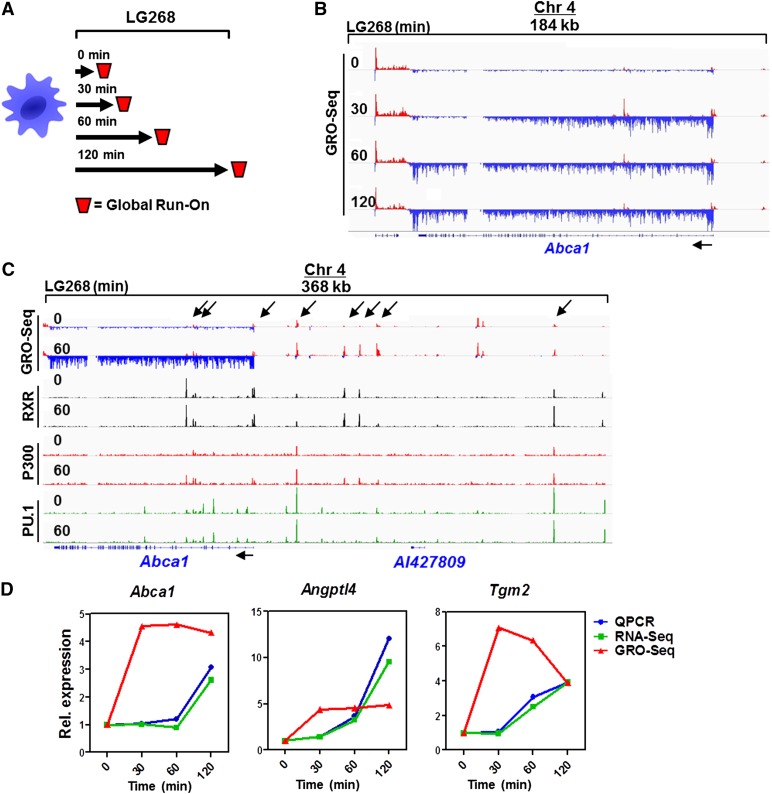
Determination of nascent RNA production upon activation of RXR. (A) The scheme of GRO-seq experiments. Cells were treated for the indicated time periods and collected, nuclei were isolated, and run-on sequencing was performed. (B) The detected induction of GRO-seq activity on the Abca1 locus. Nascent RNA produced around the Abca1 locus is shown. Strand-specific coverage is represented by red and blue. (C) Genome browser view of the merge of GRO-seq, and ChIP-seq activity/peaks on the Abca1 locus. Overlaps of PU.1, RXR, and P300 binding with divergent sites (GRO-seq-positive) are indicated with arrows. (D) Comparison of mRNA production dynamics using nascent (GRO-seq) and steady-state (RNA-seq and RT-qPCR) RNA determinations. Macrophages were treated with LG268 for the indicated time period, and specific gene expression was detected with the indicated method. A representative set of experiments is shown. Expression was normalized to the 0 time point.